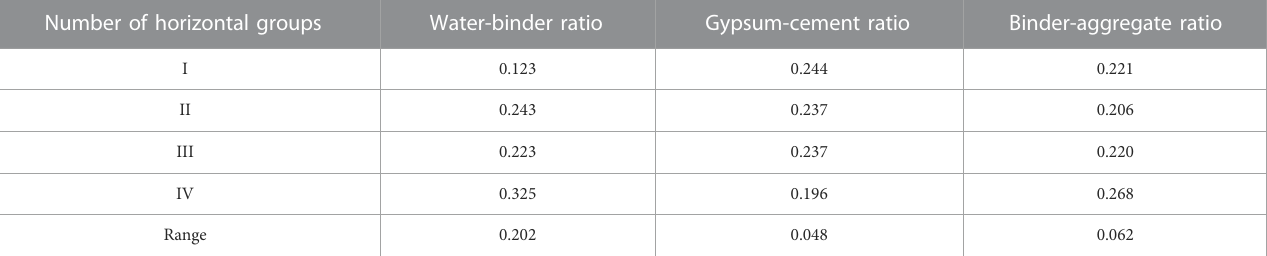
TABLE 8 Range analysis of Poisson ’ s ratio. Number of horizontal groups